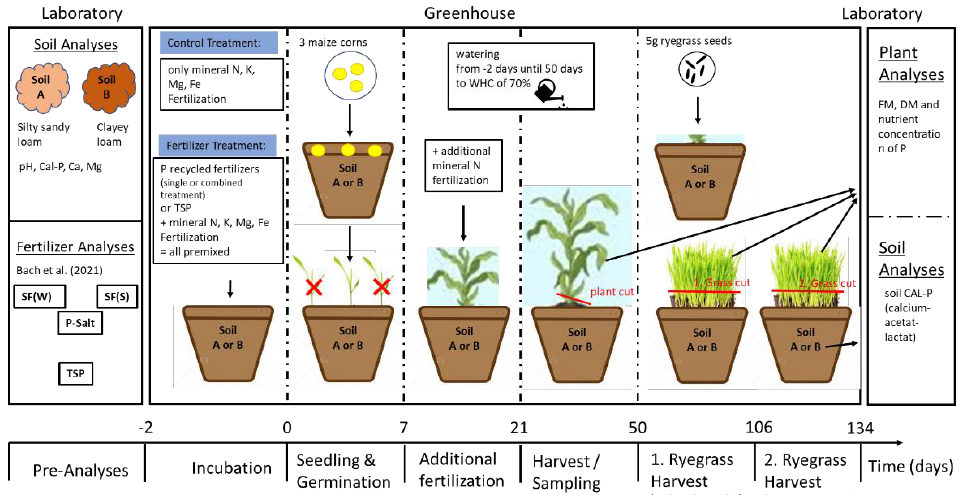
Figure 1. Experimental setup of the greenhouse pot experiment with maize followed by ryegrass. Fertilizer fractions tested were P-Salt, SF(W); SF(S), and two combinations of them, compared to unfertilized control and triple superphosphate (TSP). Maize plants were cultivated for 50 days in a silty sandy loam and clay loam soil. After maize harvest, ryegrass seeds were cultivated for 84 days with two ryegrass cuttings 56 and 84 days after sowing. DM: dry matter; FM: fresh matter; Ca: calcium, Mg: magnesium; K: potassium; N: nitrogen; Fe: iron; WHC: water holding capacity. Soil (3 kg dry weight per pot) was mixed homogeneously with the dry P fertilizer frac- tions and filled into round plastic pots (4 L volume, 20 cm diameter). Only the conventional fertilizer TSP was pre-mixed with de-ionized (DI) water to ensure exact dosage of the small amounts. Additional mineral fertilizer (Ammonium nitrate (NH 4 NO 3 ), Potassiumsulfate (K 2 SO 4 ), Magnesiumsulfate (MgSO 4 ), Fe-Sequestren (Ferric EDTA)) was given once to each pot, including the untreated controls. After fertilization, the soil was mixed again, watered to 70% of its maximum water holding capacity (WHC) and incubated for two days in a greenhouse at 24 ◦ C before sowing the maize seeds (energy crop Zea mays L. var. Carolinio (KWS SAAT SE & Co. KGaA, Einbeck, Germany)). Three seeds per pot were sown into each pot at 4 cm depth. After germination, the number of seedlings per pot